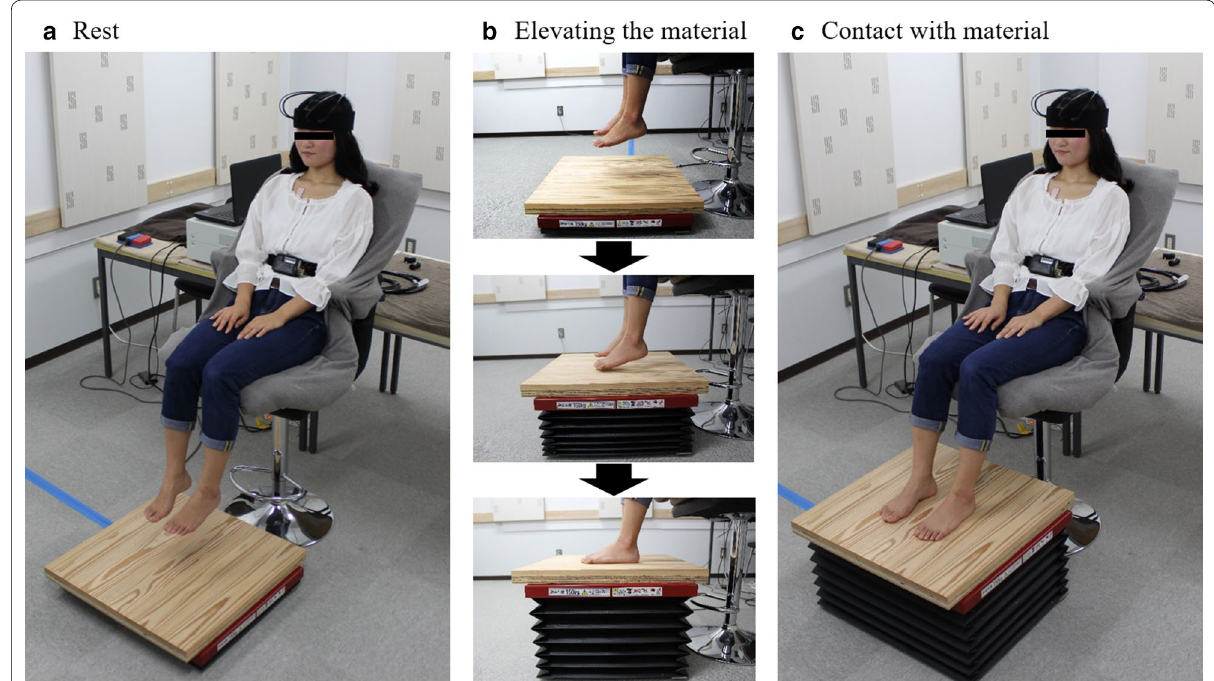
Fig. 2 Experimental scene. a Participants rested with their eyes closed for 60 s. b The sample was elevated using a scissor lift. c Participants passively contacted with material while keeping their eyes closed for 90 s